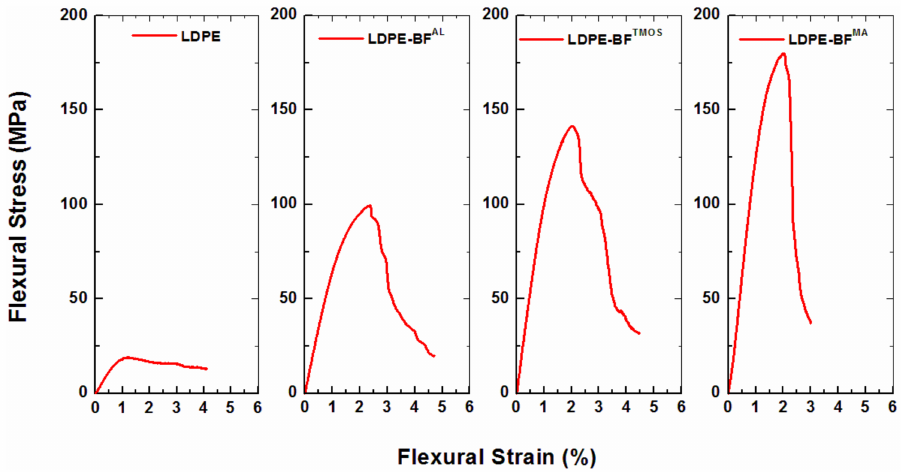
Figure 5. The flexural stress of neat LDPE and different LDPE-BFs composite sheets.